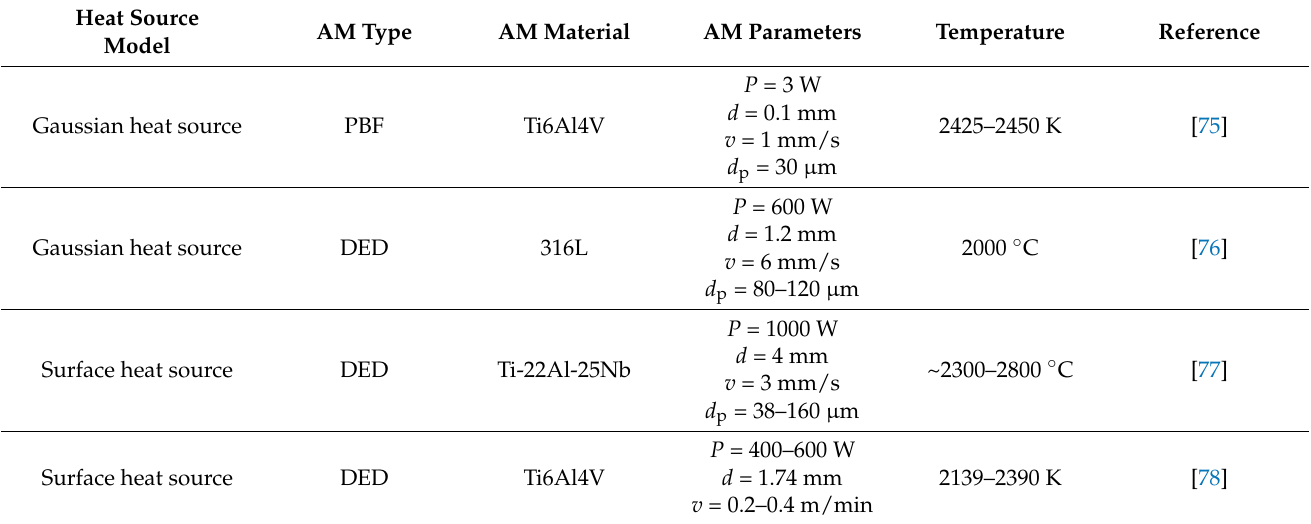
Table 1. Summaries of heat source Table 1. summaries of heat source models.